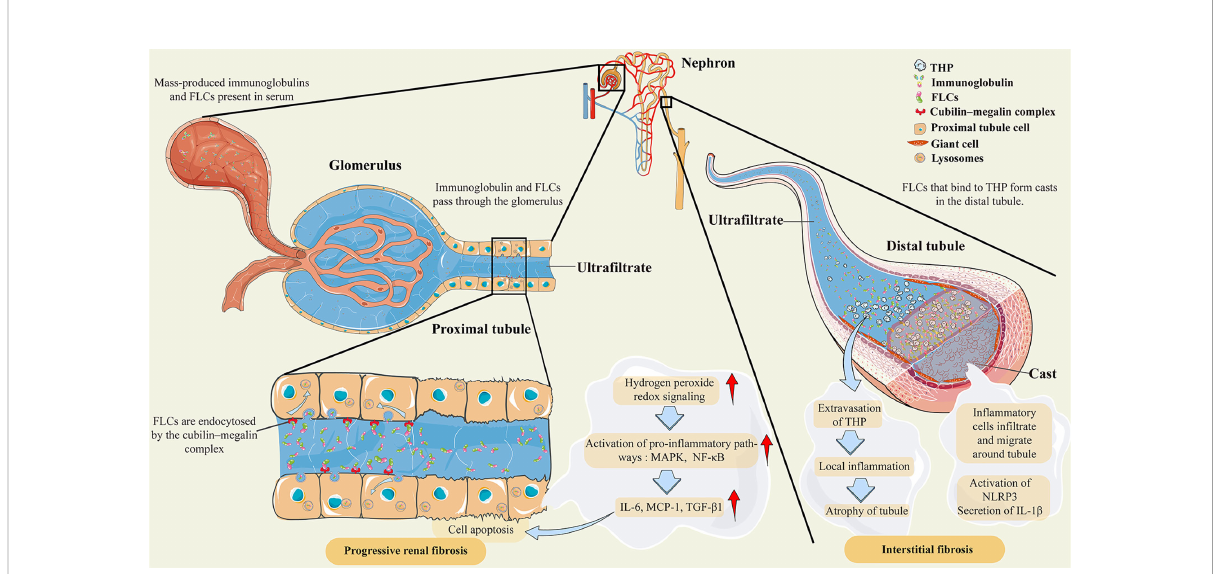
FIGURE 1 Pathological features of AKI secondary to multiple myeloma. Abbreviations: THP, Tamm – Horsfall protein; FLCs, free light chains; MAPK, mitogen-activated protein kinases; NF- k B, nuclear factor- k B; IL-6, interleukin-6; MCP-1, monocyte chemoattractant protein-1; TGF- b 1, transforming growth factor b 1; NLRP3, NOD-like receptor family protein 3; IL-1 b , interleukin-1 b . Under normal conditions, FLCs are endocytosed by the cubilin – megalin complex in the proximal tubule cell. Almost all FLCs will ultimately degrade in lysosomes. However, mass- produced immunoglobulins and FLCs are present in the serum as a result of clonal proliferation of plasma cells, exceeding the renal tubular reabsorption capacity. The massive amount of FLCs will induce hydrogen peroxide and redox signaling, leading to the activation of proin fl ammatory pathways, such as MAPK and NF- k B. Then, the transcription of in fl ammatory and pro fi brotic cytokines, such as IL-6 and MCP- 1, is initiated. In the distal tubule, FLCs can bind to Tamm – Horsfall protein to form casts that obstruct the tubules, which leads to tubular rupture and extravasation of Tamm – Horsfall protein. These effects lead to local in fl ammation, in fl ammatory cell in fi ltration, and migration around tubules, and even to atrophy of tubules. There are also postulations that the crystalline organization of casts participates in in fl ammation and giant cell reactions by activating NLRP3 and secreting IL-1 b